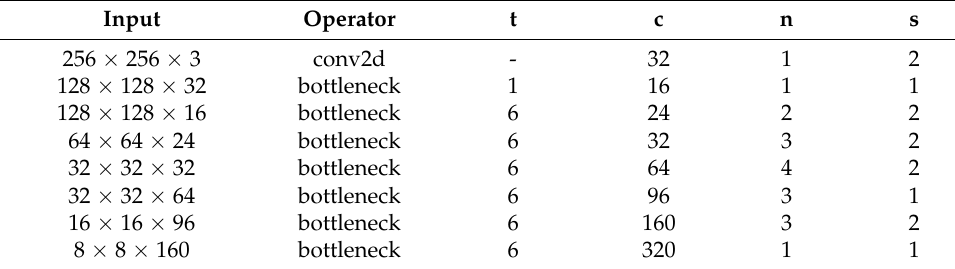
Table 1. MobileNetV2 network